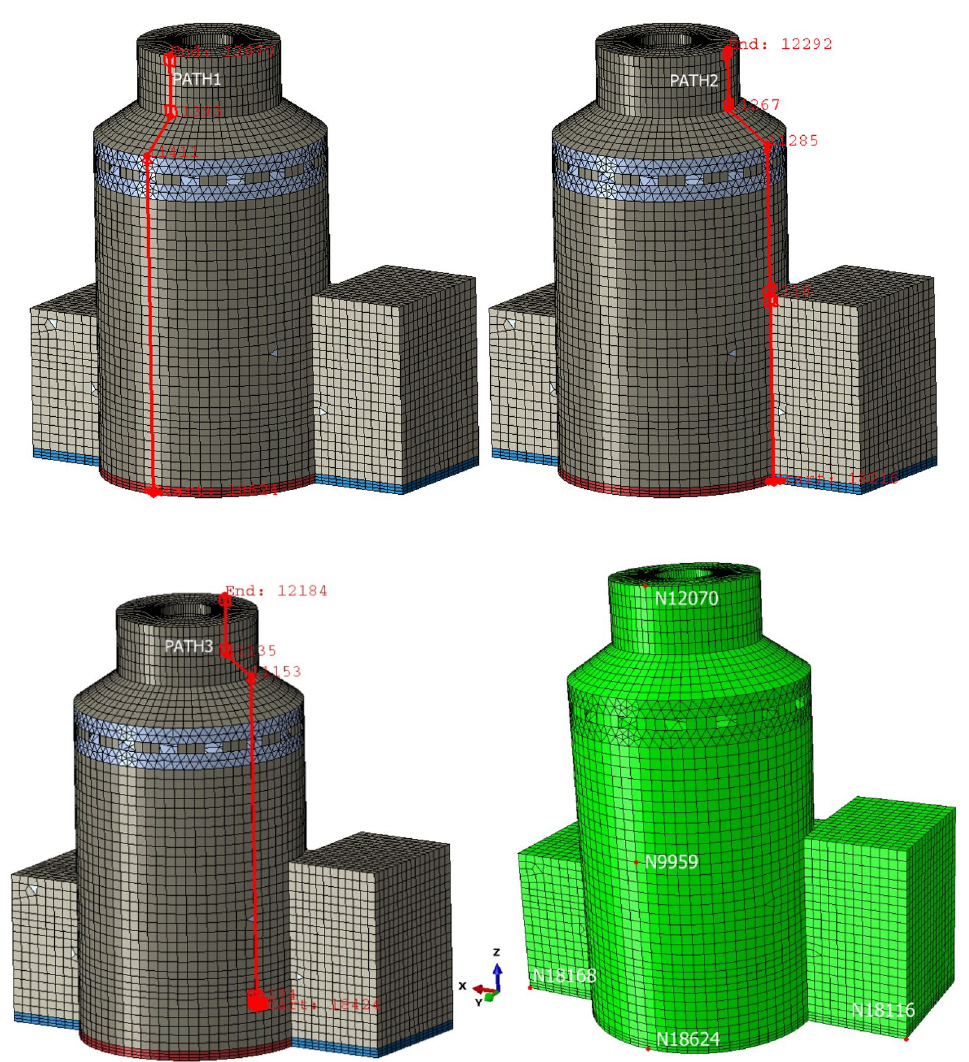
Figure 23. Locations of monitoring points of the nuclear power